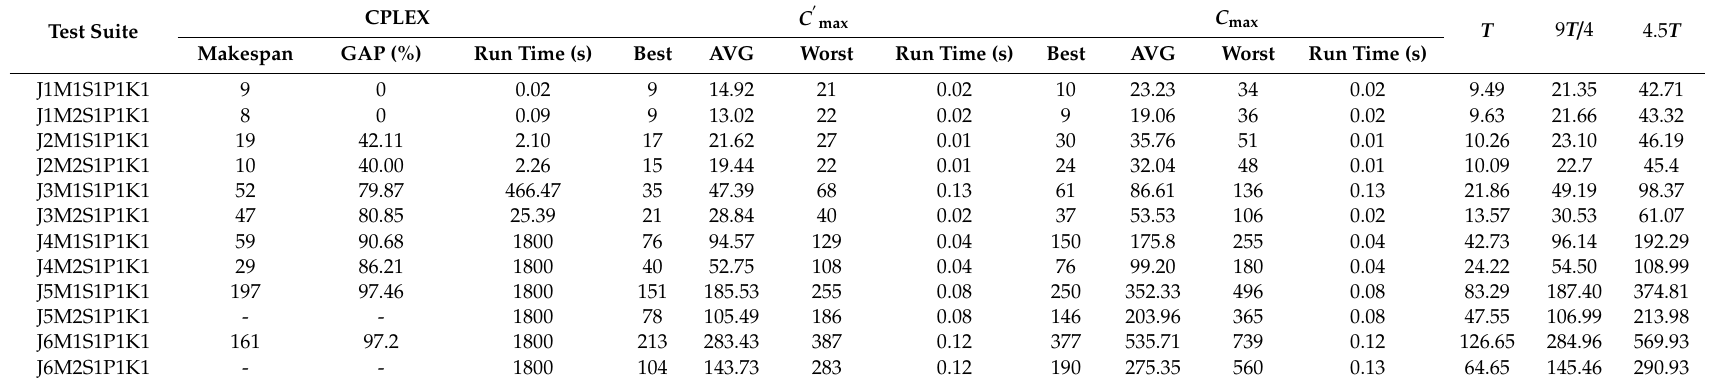
Table 5. Simulation results of CPLEX and the 4.5-approximation algorithm with one-job-overfull batches and a feasible schedule.